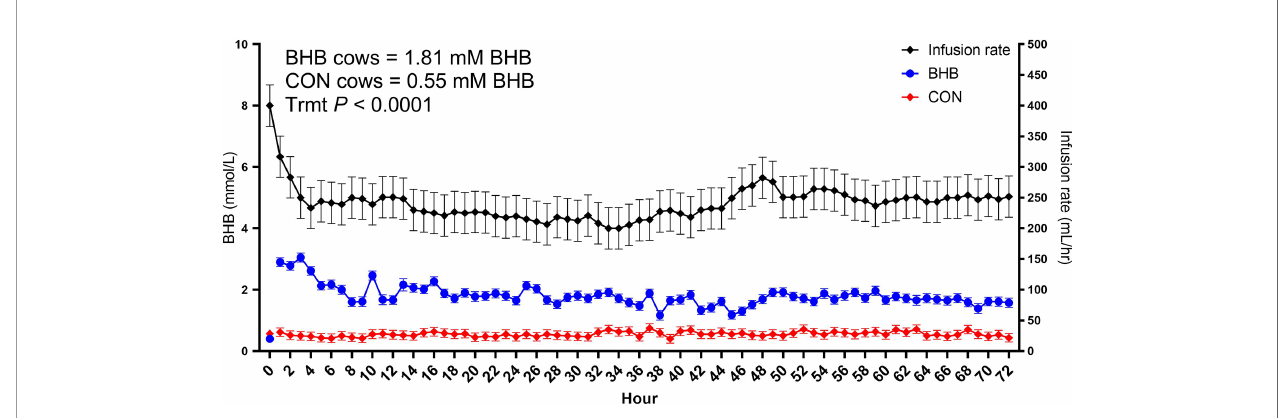
FIGURE 1 | Intravenous infusion of sodium b -hydroxybutyrate (BHB) induced hyperketonemia. Late lactation multiparous cows (n = 12) were blocked by parity and milk yield and randomly assigned to either receive a 72 h intravenous infusion of 2.5 M Na-BHB or 2.5 M NaCl (CON). Blood BHB concentrations were monitored on an hourly basis, and the infusion rate was adjusted accordingly to maintain a target concentration of 1.8 mM BHB in the BHB-infused cows. Infusion rates were matched between CON and BHB cows to equilibrate sodium concentrations of the infusate between cows. All cows were challenged with S. uberis in the right rear and right front quarters of the mammary gland at the start of the infusion. Data are presented as LSM ±